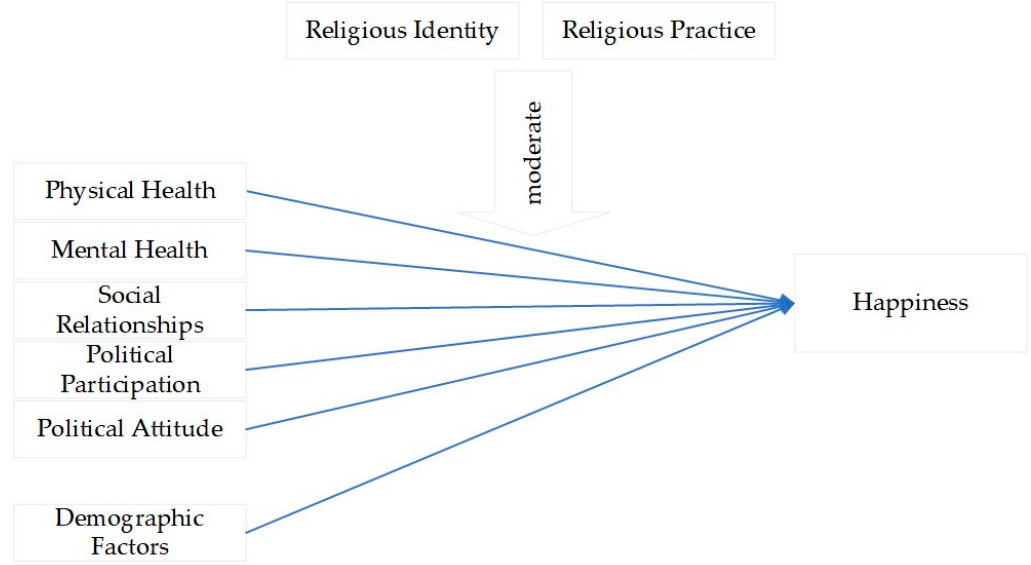
Figure 1. Research framework for the determinant factors of happiness as moderated by religious identity and practice.